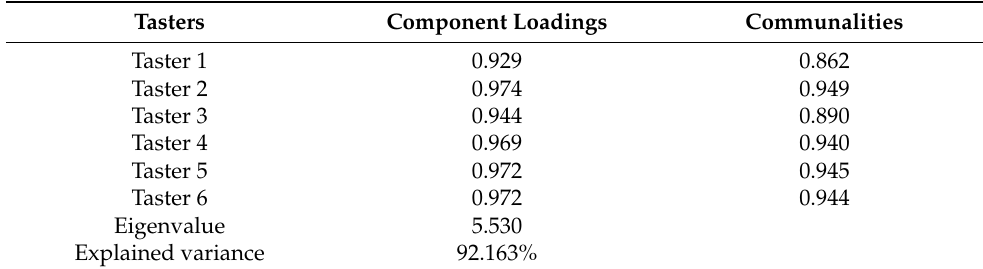
Table 7. Component loadings, communalities, eigenvalue and explained variance for PP2. Tasters Component